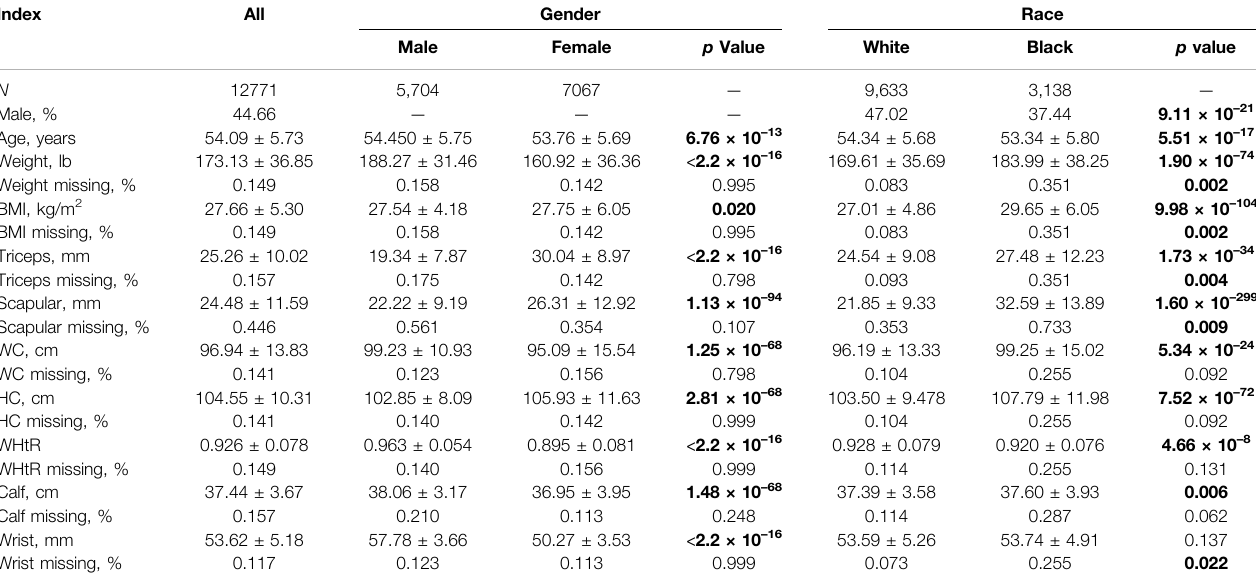
TABLE 3 | The descriptions of involved obesity-related phenotypes and covariates in